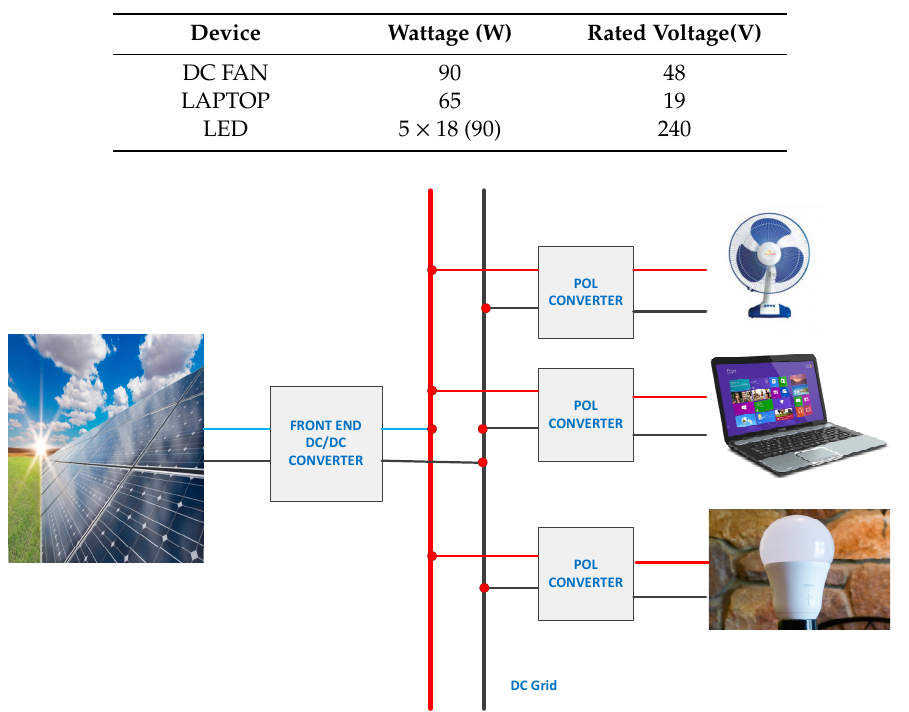
Figure 2. Proposed Schematic for the proposed circuit topology.